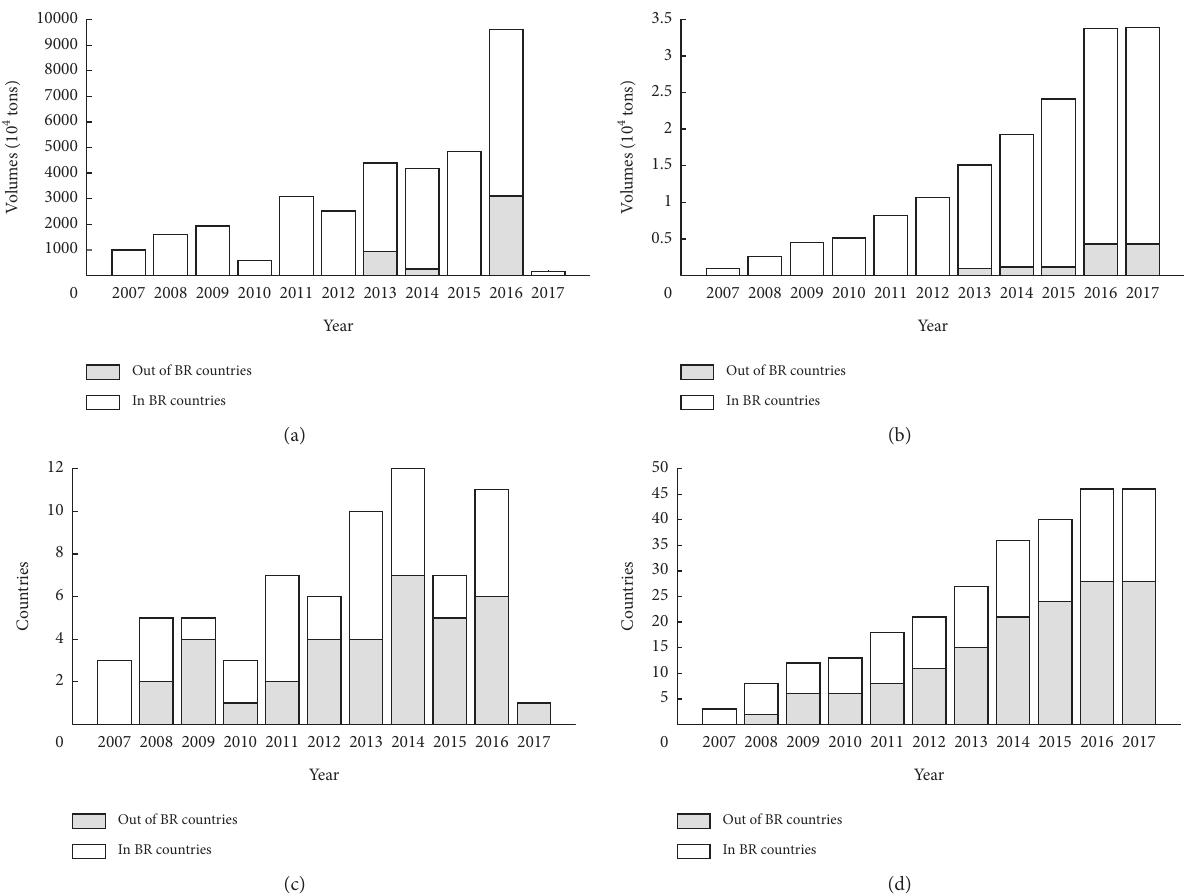
Figure 20: China’s overseas shipping construction projects in or out of BR (2005–2017): (a) annual millions; (b) accumulated millions; (c) annual countries; (d) accumulated